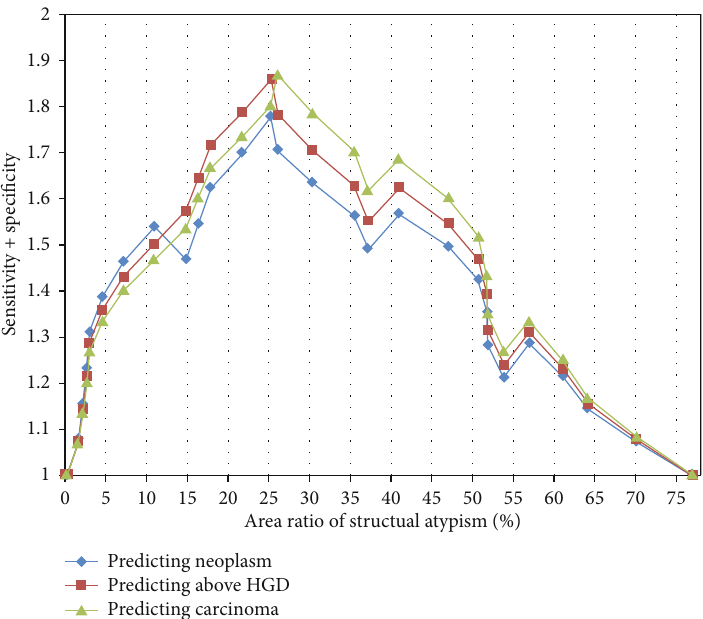
Figure 3: Sum of the sensitivity and speci fi city for predicting fi nal diagnoses according to area ratio with structural atypia to total inde fi nite for dysplasia by plotting receiver operating characteristic curves. Cut-o ff values were de fi ned as 25.3% for neoplasm, 25.3% for above high- grade dysplasia, and 26.1% for